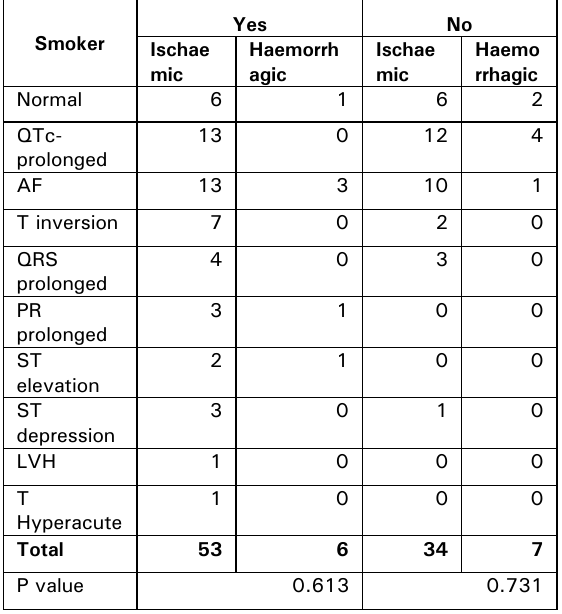
Ischaemic and Haemorrhagic Stroke with and without